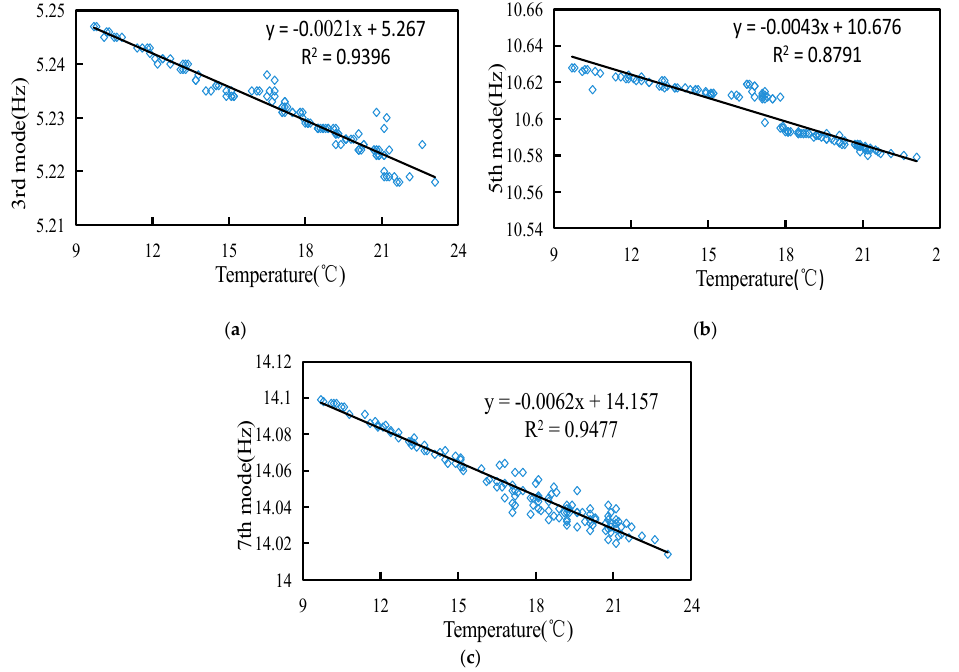
Figure 12. Fitted curves of ambient temperature and modal frequency: ( a ) fitted curve of ambient temperature and 3rd modal frequency; ( b ) fitted curve of ambient temperature and 5th modal frequency; ( c ) fitted curve of ambient temperature and 7 th modal frequency.